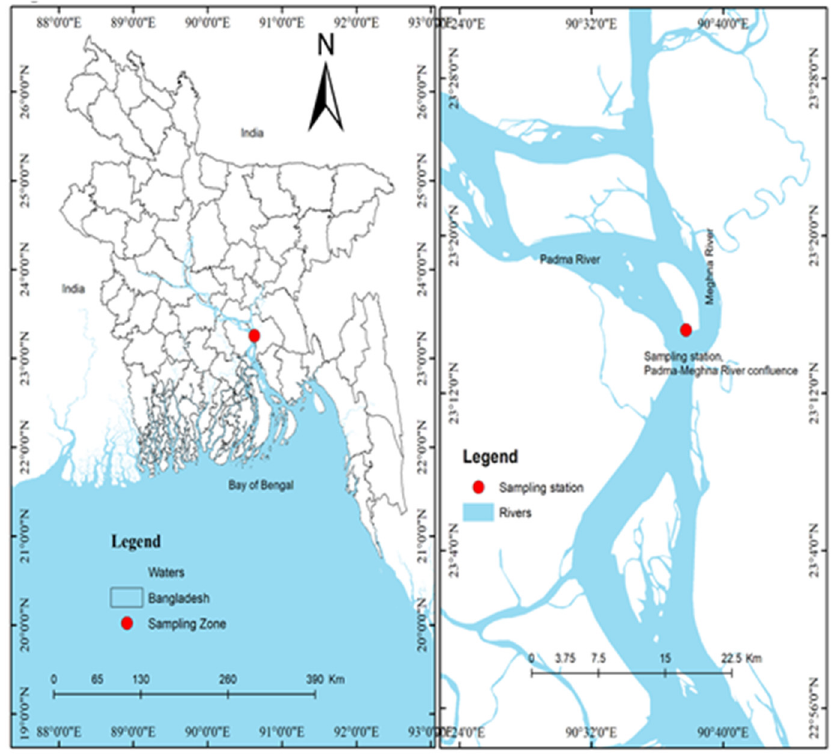
Figure 1. Study area and station location at the Padma–Meghna River confluence. Both the Padma and Jamuna River confluence receive around 85% water flow from the North-West latitude, while the residual 15% flow is received from the Meghna River from the North-East latitude of Bangladesh [49]. Annually, the upstream receives 3000–4900 mm and the downstream receives 1500–2400 mm rainfall. Usually, the upstream precipitates 52% (1600–2500 mm) and the downstream precipitates 60% (900 mm to 1500 mm) rainfall during June to August [49]. Globally, the highest amount of sediment and the third-highest amount of water is discharged by the Meghna River confluence [49]. This is the widest (12 km downstream) river with 264 km long, having 82,000 km 2 of total catchment area [37]. The average and maximum depth of the Meghna river is 308 m and 490 m, while the Padma river’s average and maximum depth are 295 m and 479 m, respectively. This river ecosystem has been recognized as one of the weighty nurseries and breeding grounds for T . ilisha in Bangladesh [26]. Various sizes of T . ilisha were caught using gill nets by local fishers, and 12 water samples (four of each at < 1.0, ~ 5.0, and < 10.0 m depth, respectively) were collected using a Van Dorn water sampler in August (2019) at the Padma–Meghna River watershed and the surrounding areas of the Chandpur district (Figure 1). A total of 300 T . ilisha specimens were iced and packed in an air-tight insulated box. The